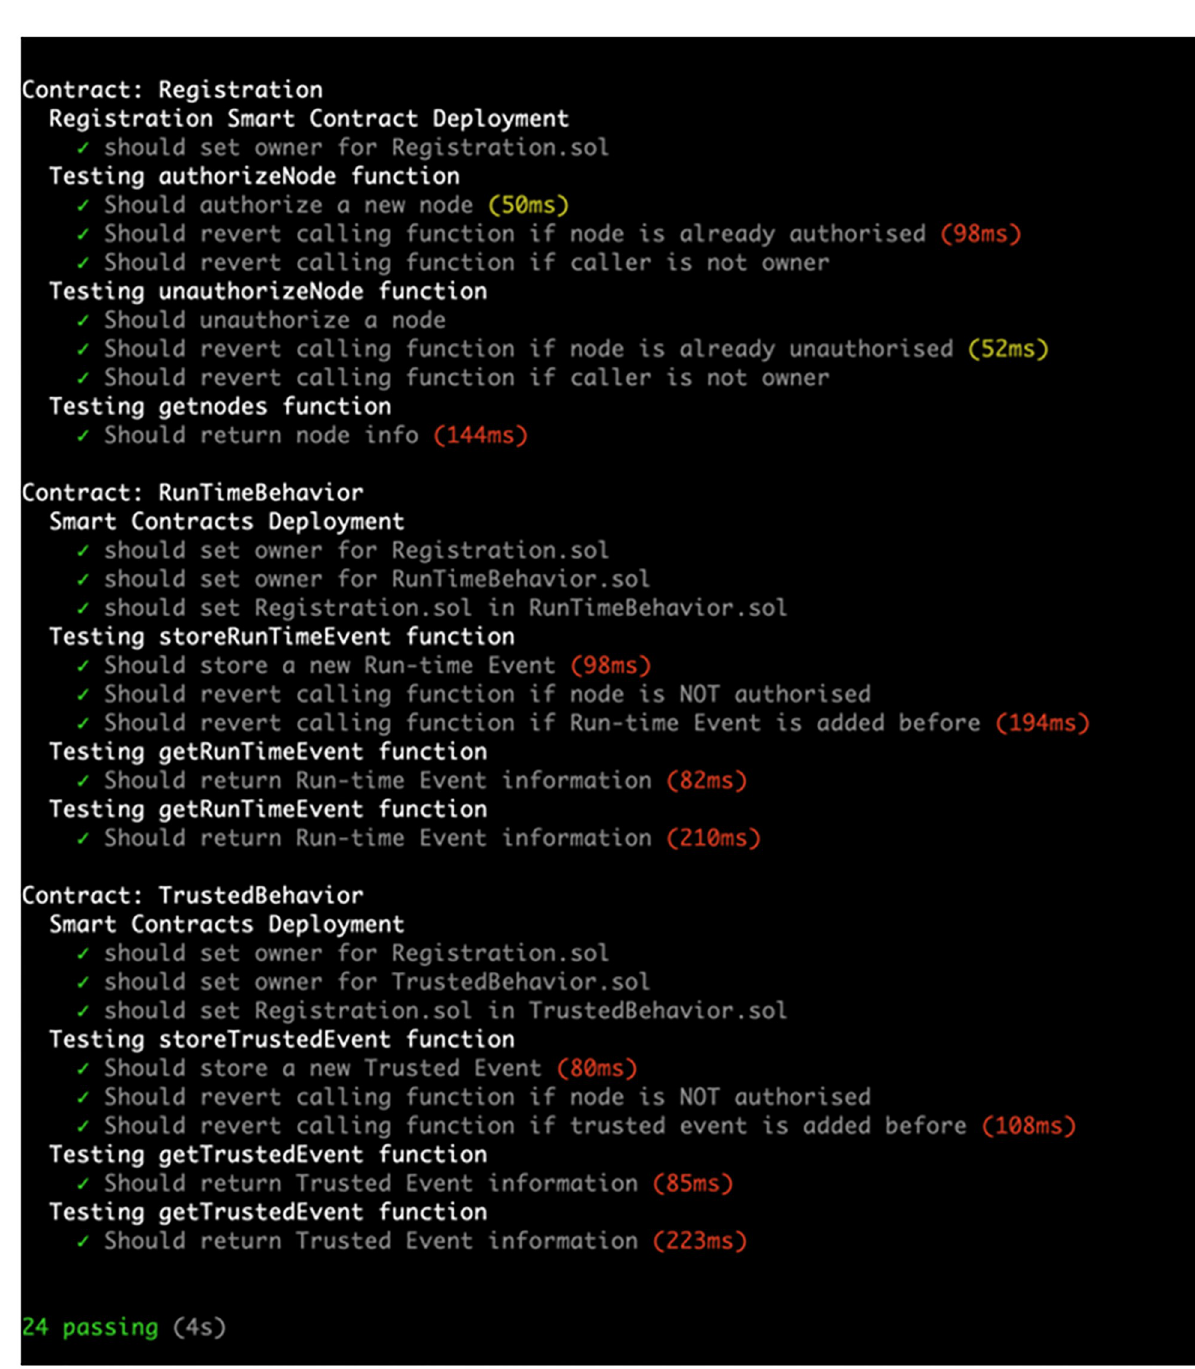
Fig 7. The result of smart contract testing